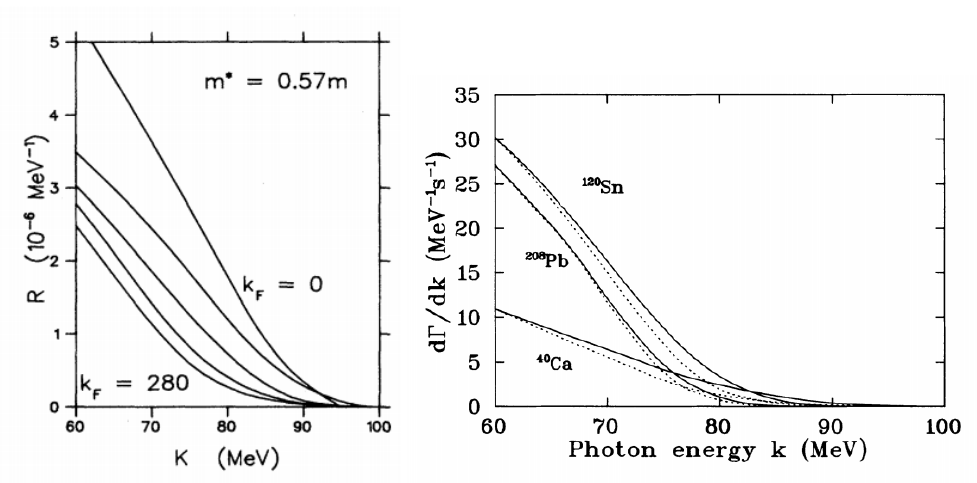
Figure 4. RMC spectra vs. k Fermi [62] ( left ) and example RMC spectra[63] ( right ) as calculated using a Fermi gas model. In the left figure, m ∗ is the effective mass used in the calculation and the different lines correspond to k F values of 0, 70, 140, 210, and 280 MeV from top to